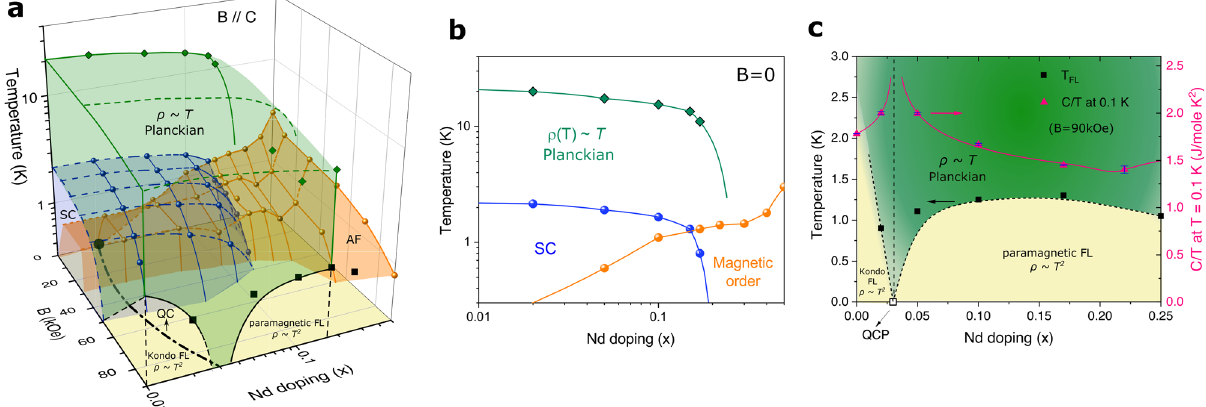
Fig. 1 | The phase diagram for Ce 1 − x Nd x CoIn 5 for B ∥ c . a The ( x , B , T ) phase dia- gram: the antiferromagnetic (AF) Néel state occurs below the orange area and the superconducting(SC)phasesetsinunderthebluearea(symbols).Thedataofzero- fi eldplaneisreproducedfromFig.6ofref. 26 .AQCPispredictedonthedopingaxis near x ≈ 0.03atzero fi eldplane,hiddenbeneaththecoexistingphaseoftheAFand SCphases.AttemperatureabovetheSCandAFphasesandbelowthegreenregion, this material shows linear-in- T strange-metallic (SM) behavior. A quantum critical (QC) line (black dotted-dashed line) is expected to exist at fi nite fi eld and Nd doping, connected to the QCP at zero fi eld, x = x c . b Phase diagram of a on the